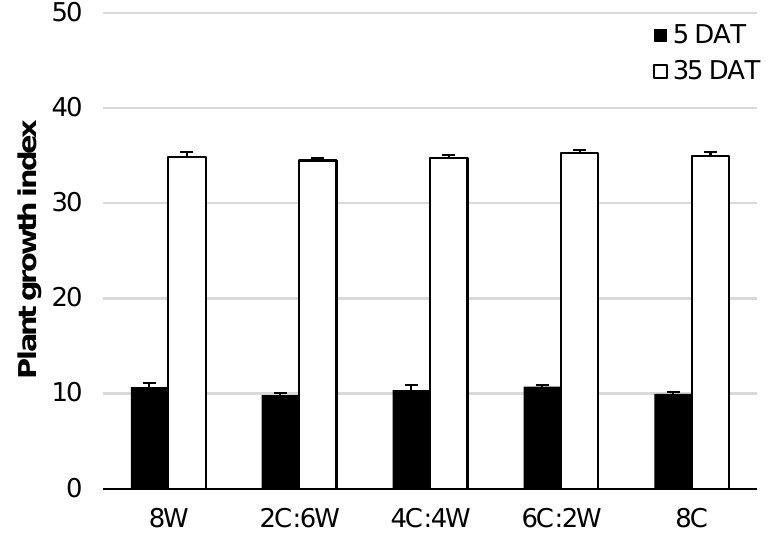
Figure 6. Plant growth index 5 and 35 DAT. Vertical bars denote standard errors of means. The measurement of relative chlorophyll fluorescence [Fv/Fm] did not indicate any sig- nificant differences associated with the substrate treatments from 5 until 35 DAT (Figure 7). On the contrary, the relative optical chlorophyll content [SPAD] significantly increased in the substrate treatment of 8W, 8 DAT (36.13 ± 1.02) until 35 DAT (38.88 ± 0.3) compared to the substrate of 8C (33.75 ± 0.76 and 36.78 ± 0.40, respectively) (Figure 8).